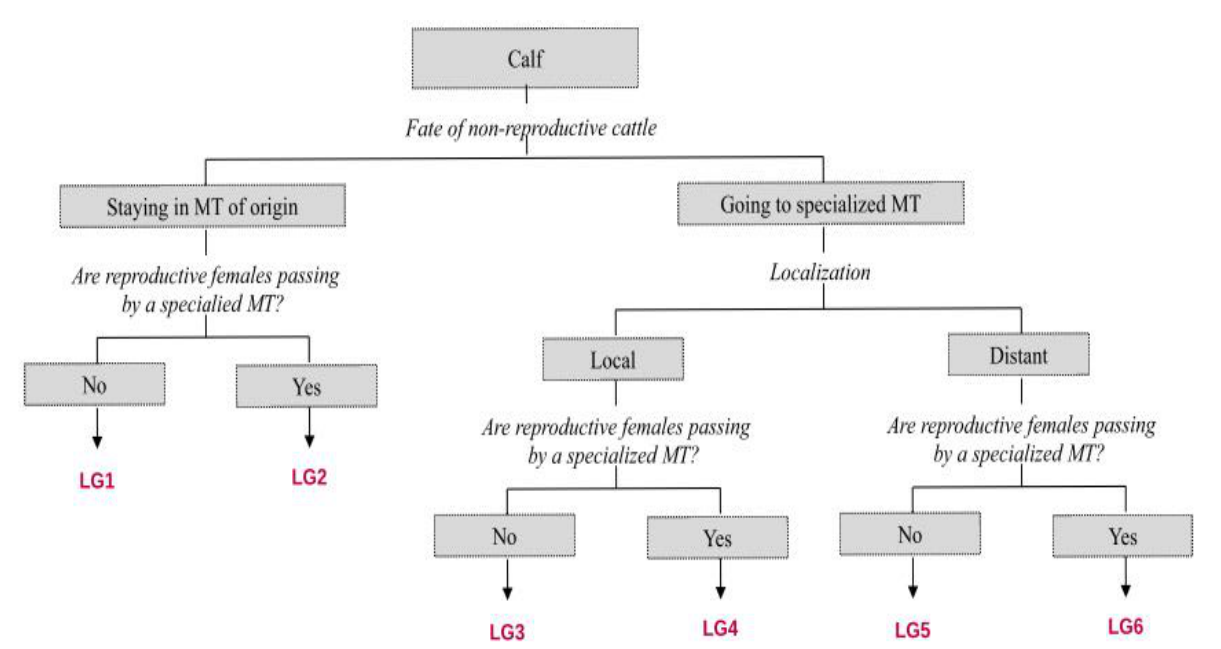
Figure 4. Decision tree for the construction of the LG typology.